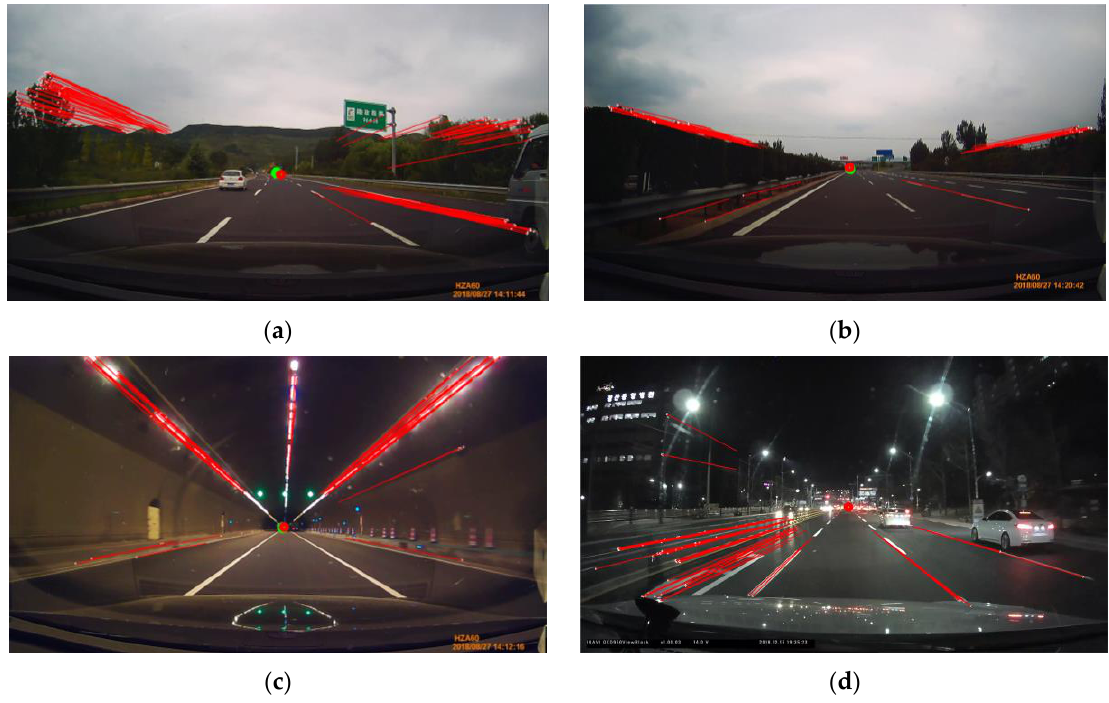
Figure 7. Some examples of the proposed motion-based R-VP detection in various illumination conditions such as ( a ) bright and ( b ) slightly dark daytime, ( c ) tunnel, and ( d ) nighttime. Note that ground-truth R-VP is not indicated in ( d ). Table 2. The performances of the proposed method with reduction of type 2 and type 3 under three different illumination conditions of driving scenes such as bright days, slightly dark days, and in-tunnels.